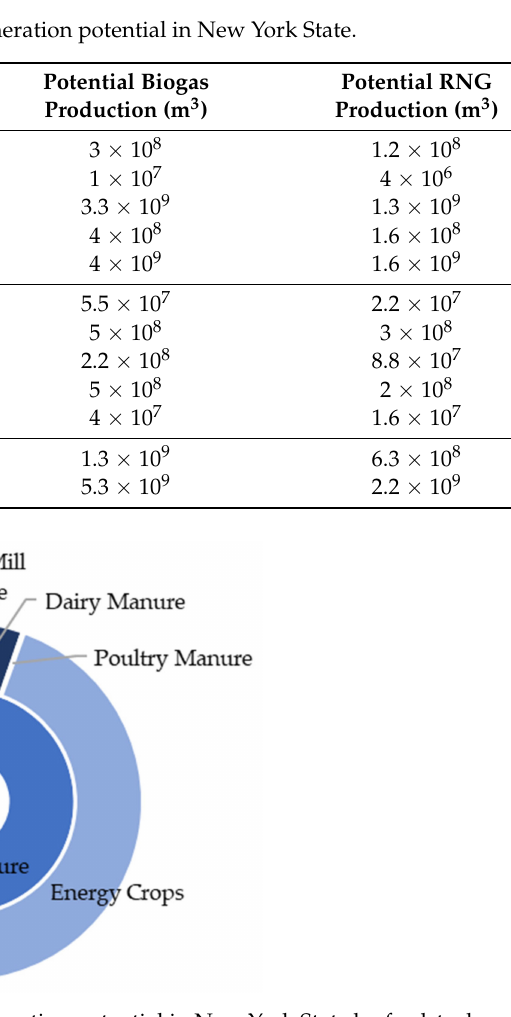
Figure 1. Anthropogenic annual RNG generation potential in New York State by